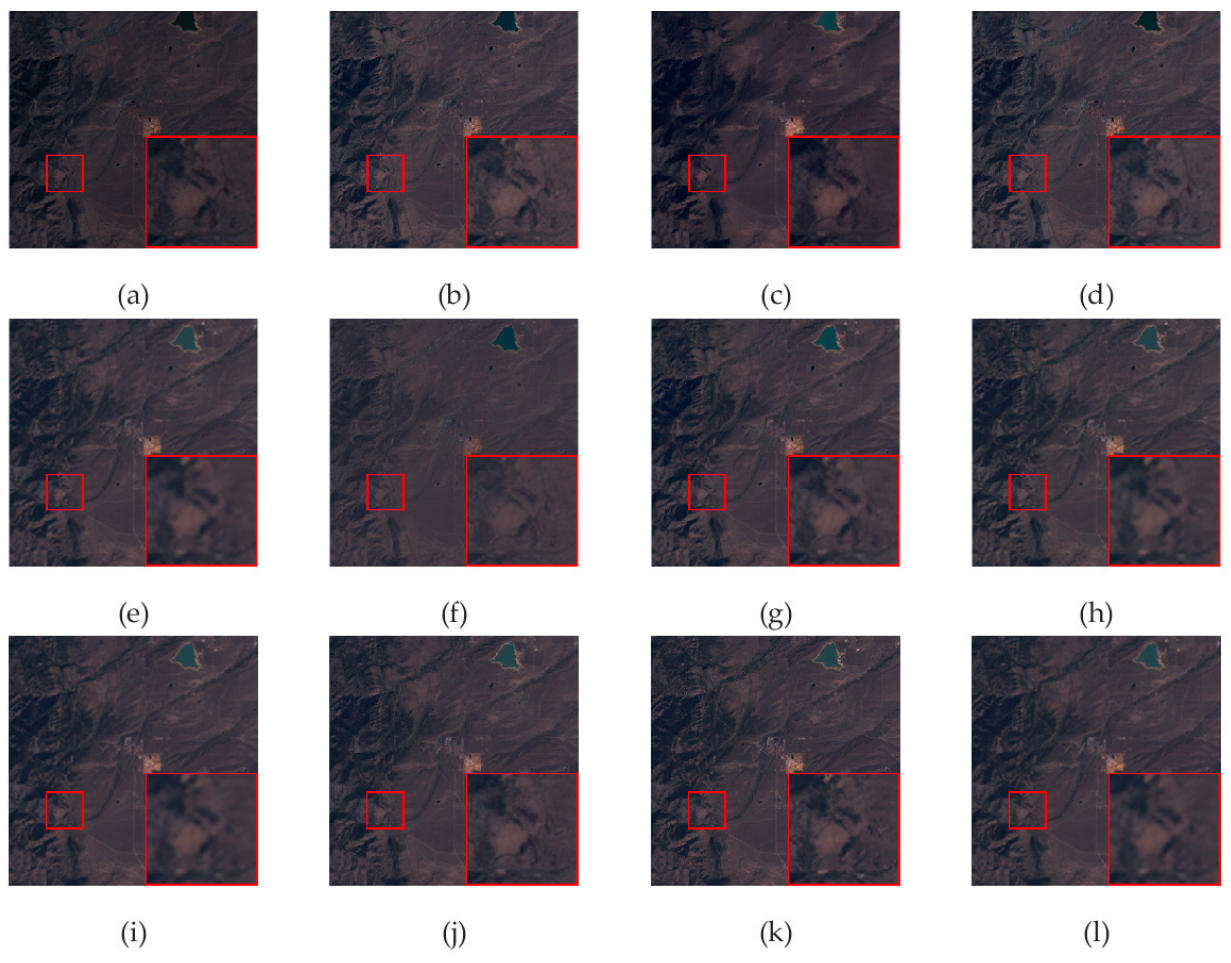
Figure 9. The fusion results of ten different methods on the fourth image pair: ( a ) BT; ( b ) GSA; ( c ) GF; ( d ) IHS; ( e ) MOD; ( f ) PCA; ( g ) PRACS; ( h ) VLGC; ( i ) BDSD-PC; ( j ) WT; ( k ) the proposed method; ( l ) the reference MS image. Table 5. Objective evaluation of the experimental results on the fourth image pair.